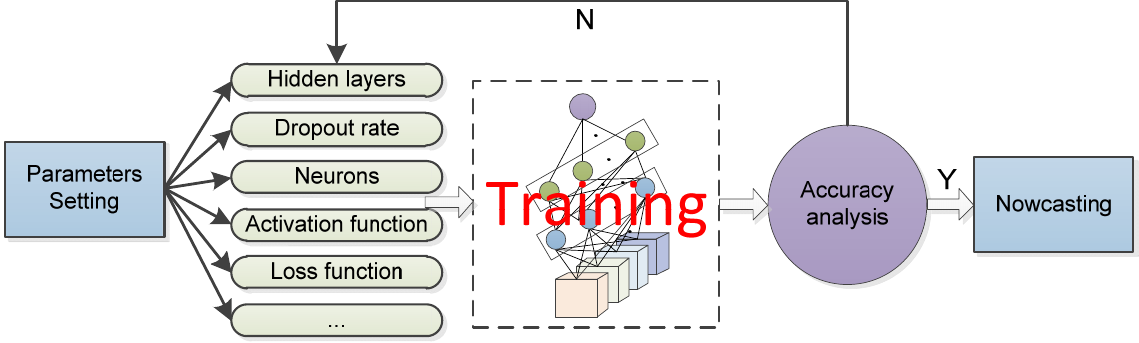
Figure 7. EDH nowcast model.